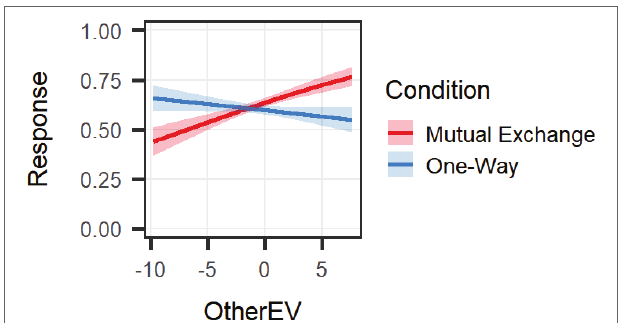
FIGURE 1 | Interaction of Condition with OtherEV on the decision to take a gamble. Participants in the Mutual Exchange condition were more likely to take gambles that were good for the other and pass on gambles that were bad for the other, while those in the One-Way condition did not use OtherEV when making